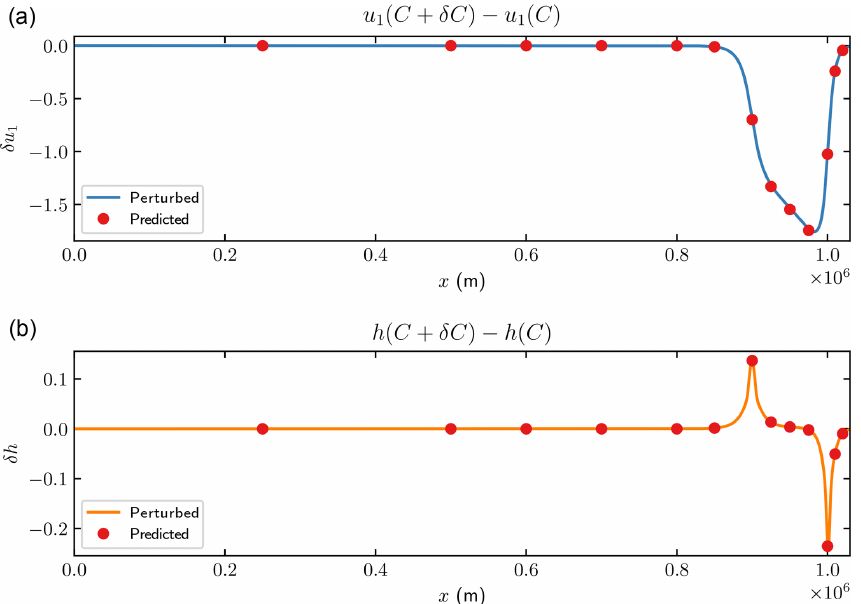
Figure 4. The changes on the horizontal velocity u 1 (a) and surface elevation h (b) in FS after 1 year with 1% perturbation on C(x) at x ∈ [ 0 . 9 , 1 . 0 ]× 10 6 m. Solid lines are the differences between the steady-state and perturbed transient solutions in Eq. (5). Red dots are the estimated perturbation using Eq.